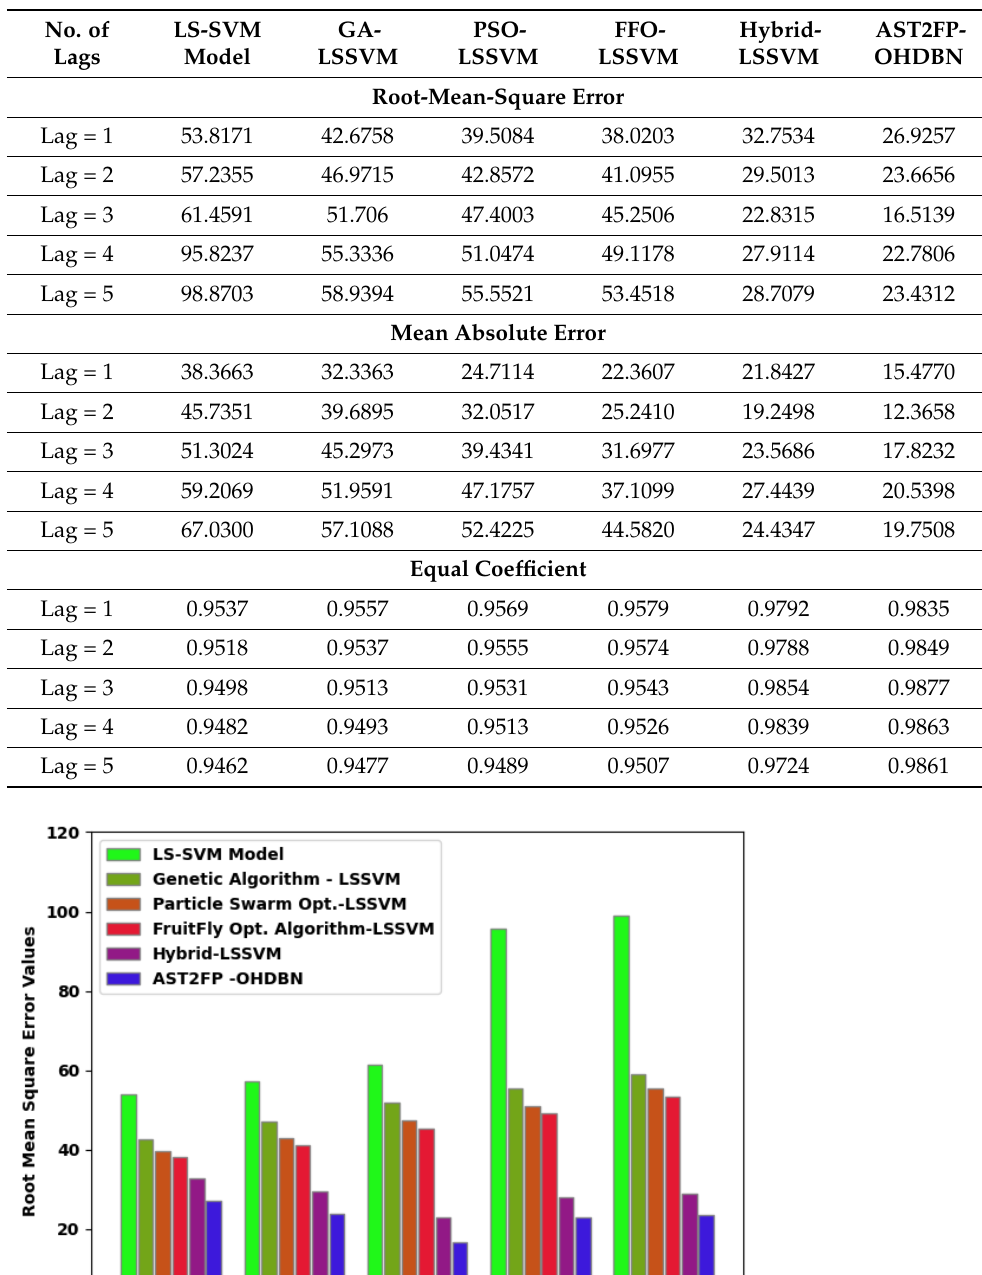
Table 3. Comparative analysis of AST2FP-OHDBN approach with existing methodologies under various measures.